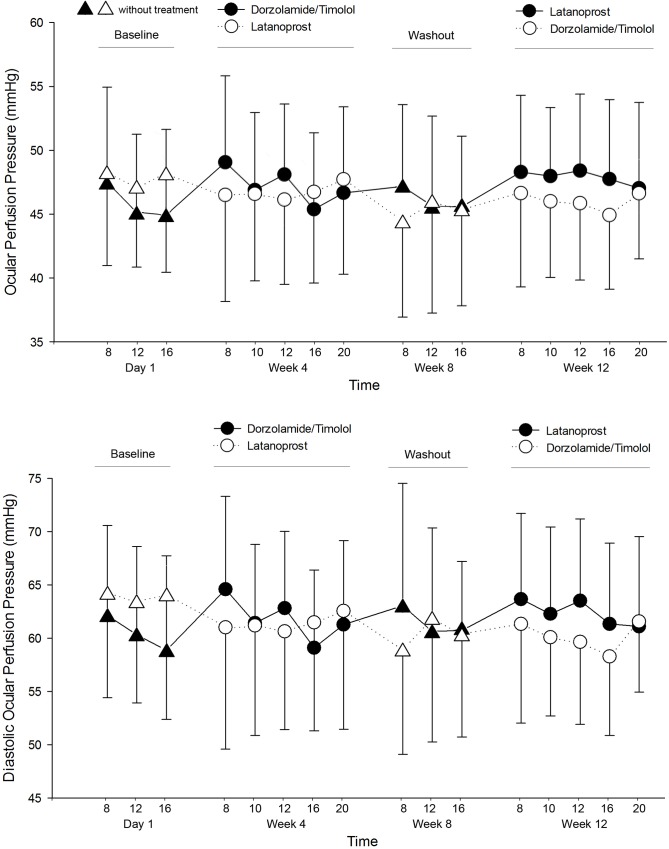
Mean ocular perfusion pressure and diastolic ocular perfusion pressure during the circadian curve for the three crossover phases: at baseline, after dorzolamide/timolol, and after latanoprost.Vertical bars indicate the 95% confidence interval of the estimates.